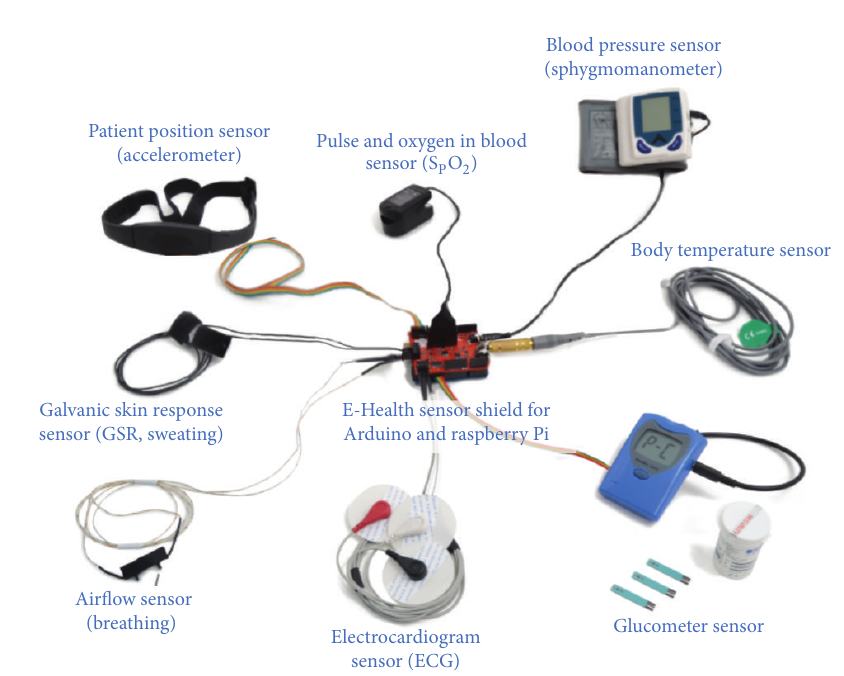
Figure 10: Cooking development kit used in the MCT (adapted from